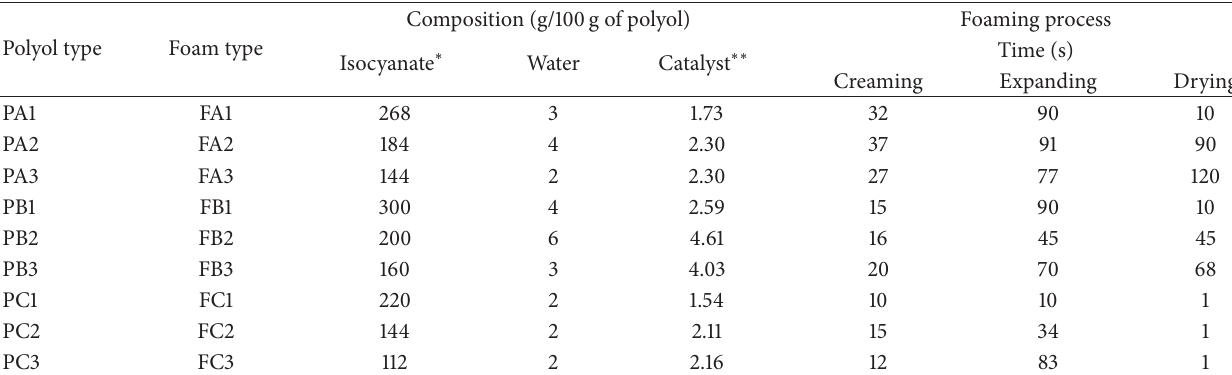
Table 4: Impact of polyol composition on foaming process.